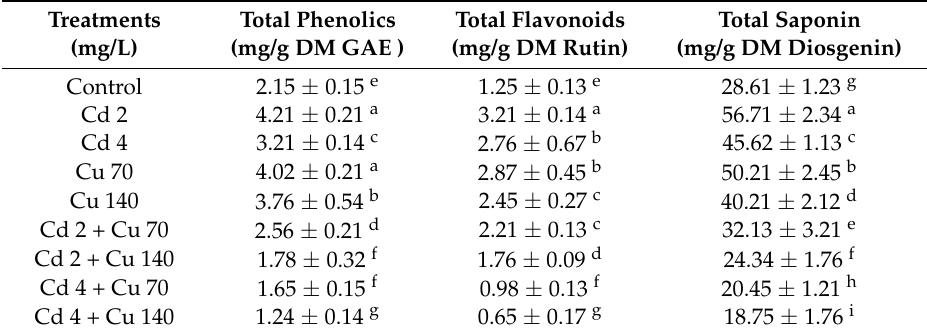
Table 4. Total phenolics, total flavonoids and total saponin content of Gyanura procumbens under different cadmium and copper